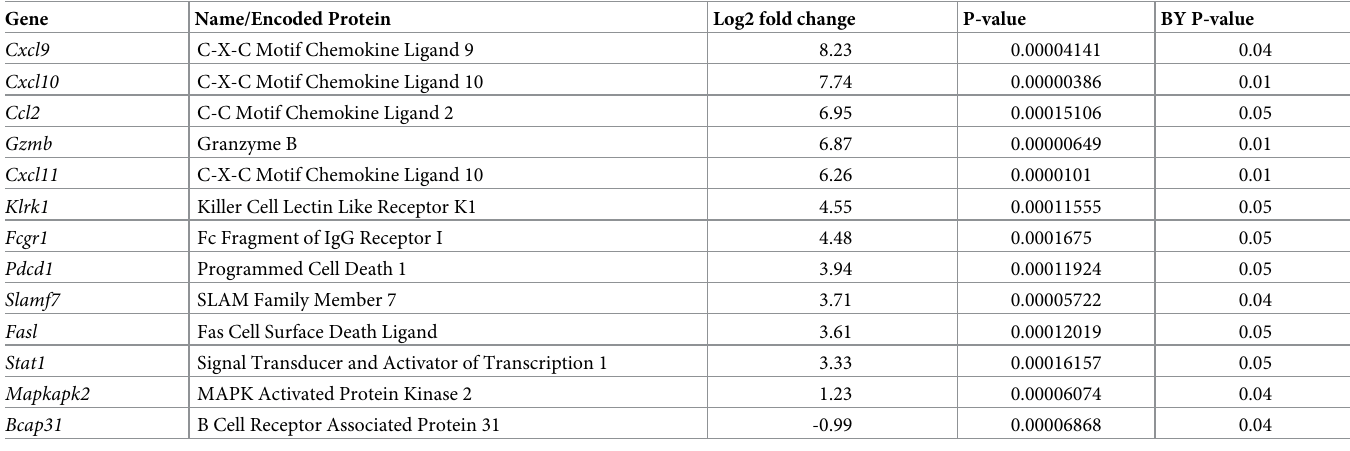
(Fig 6A). Other cytotoxicity-associated genes, including Slamf7 , Fasl , and Klrk1 , were upregu- lated at both days 8 and 12 (Tables 1 and 2). Meanwhile, Il11ra1 , Traf4 , Illrl2 , and Mr1 were downregulated at day 8, while Bcap31 was downregulated at day 12 (Tables 1 and 2). Inflam- matory markers identified through our differential expression analysis were verified through qRT-PCR, confirming the high expression of Cxcl9 , Cxcl10 , Cxcl11 , IFN γ , and TNF α on day 10 (Fig 6B). Selectively upregulated or downregulated genes were also verified through qRT-PCR (Fig 6C and 6D), respectively. Our findings of type 1-skewed responses in lethal CD-1 models corroborated with our previous reports in the lethal B6 models [27,48,50,52]. Table 2. Differentially expressed genes filtered by adjusted test statistic (D12 vs.